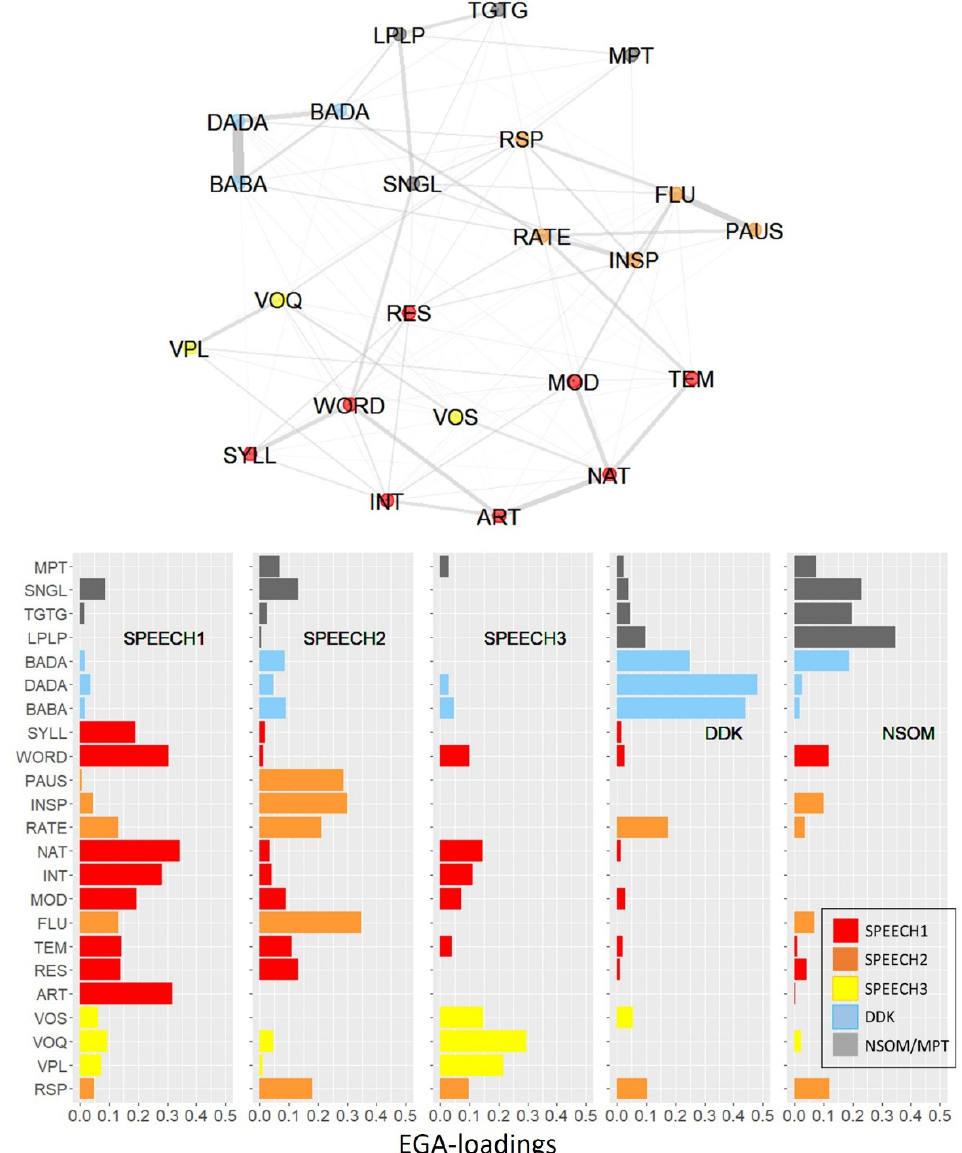
Figure 2. Exploratory graph analysis of all standardized assessment parameters in the patient sam- ( n = 130). ( Top ): graphical solution. ( Bottom ): Loadings of EGA-dimensions on parameters. Red: ple ( n = 130). Top: graphical solution. Bottom: Loadings of EGA-dimensions on parameters. Red: SPEECH 1; orange: SPEECH 2; yellow: SPEECH3; blue: DDK syl ; grey: SPEECH 1; orange: SPEECH 2; yellow: SPEECH3; blue: DDK syl ; grey: NSOM/MPT .